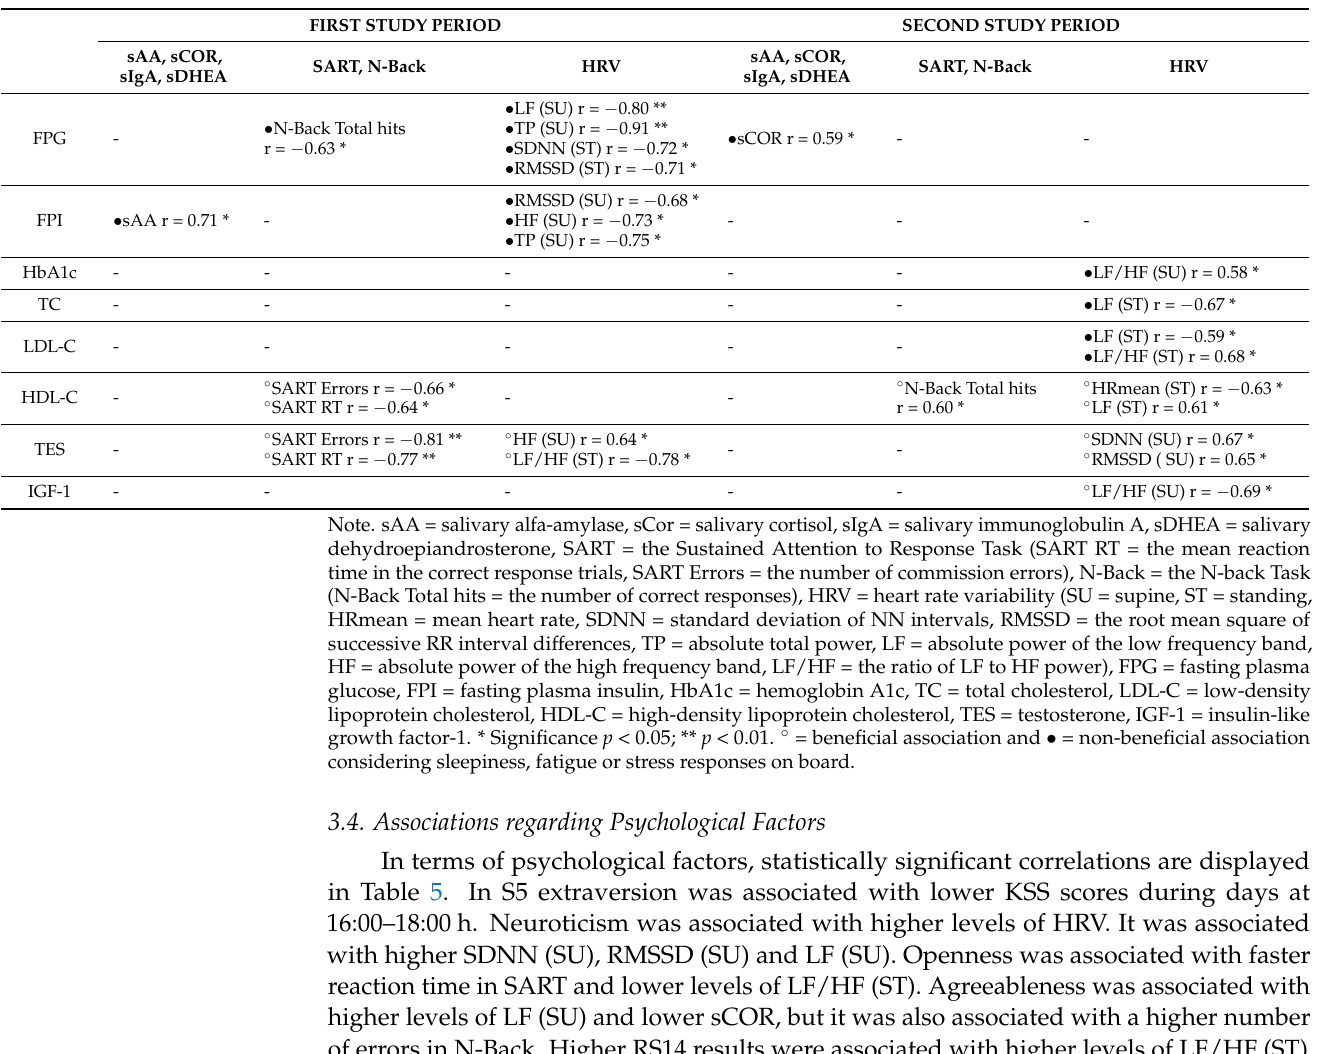
Table 4. Statistically significant correlations regarding blood biomarkers.